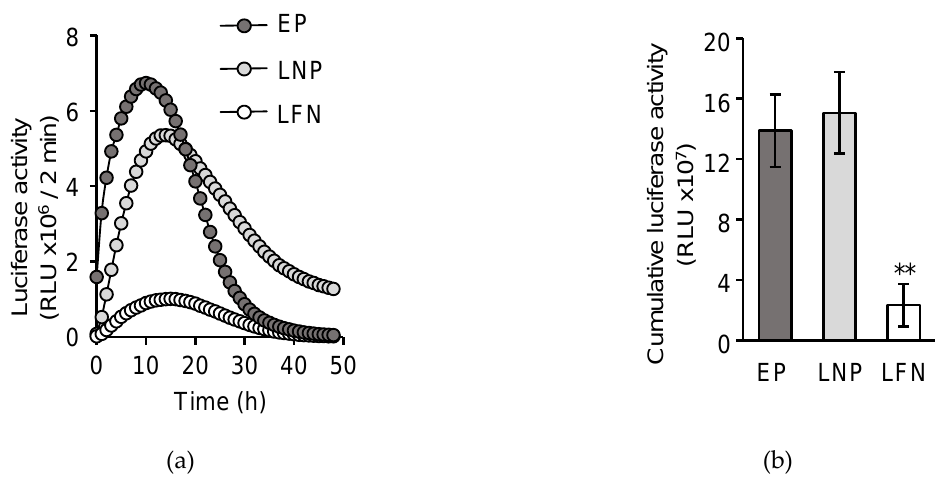
Figure 3. Transfection efficiency of the LNP ssPalm and other transfection methods. ( a ) Comparison with the general transfection procedures. The transfection activity of the LNP ssPalm was compared to the electroporation (EP) or a commercially available lipofection reagent (lipofectamine messengerMAX; LFN). The luminescence from the cultured cells was measured for 2 min in the incubator-type luminometer. Cumulative light unit for 2 min was plotted against time, transfected with mRNA. The mean of the independent experiments is shown ( n = 3). ( b ) Cumulative luciferase activity. The transfection activity was accumulated for 48 h. Data were represented as mean ± SD ( n = 3) . Statistical analysis was performed by One-way ANOVA followed by Tukey – Kramer test, **; p < 0.01 against LFN.